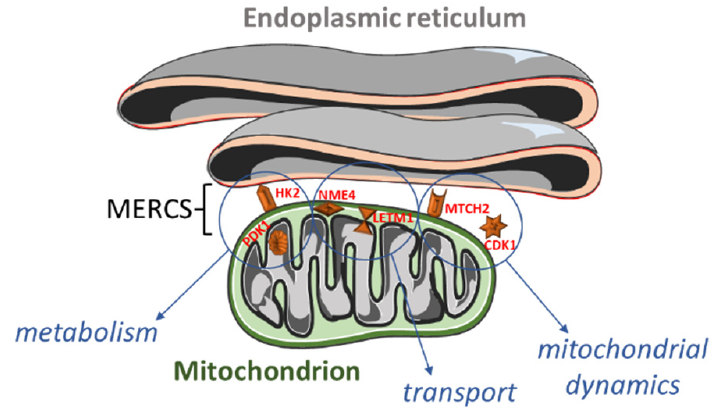
Figure 1. Overview of the proteins localized within or close to mitochondria–endoplasmic reticulum (ER) contact sites (MERCS) and their functions. Hexokinase 2 (HK2; outer mitochondrial membrane) and pyruvate dehydrogenase kinase 1 (PDK1; mitochondrial matrix) are involved in the (carbohydrate) metabolism. NME/NM23 nucleoside diphosphate kinase 4 (NME4; mitochondrial intermembrane space) and leucine zipper and EF-hand-containing transmembrane protein 1 (LETM1; inner mitochondrial membrane) participate in the cardiolipin and calcium transport. Finally, mitochondrial carrier 2 (MTCH2; outer mitochondrial membrane) and cyclin B1-dependent kinase 1 (CDK1; cytoplasm, mitochondrion, nucleus) regulate mitochondrial dynamics.